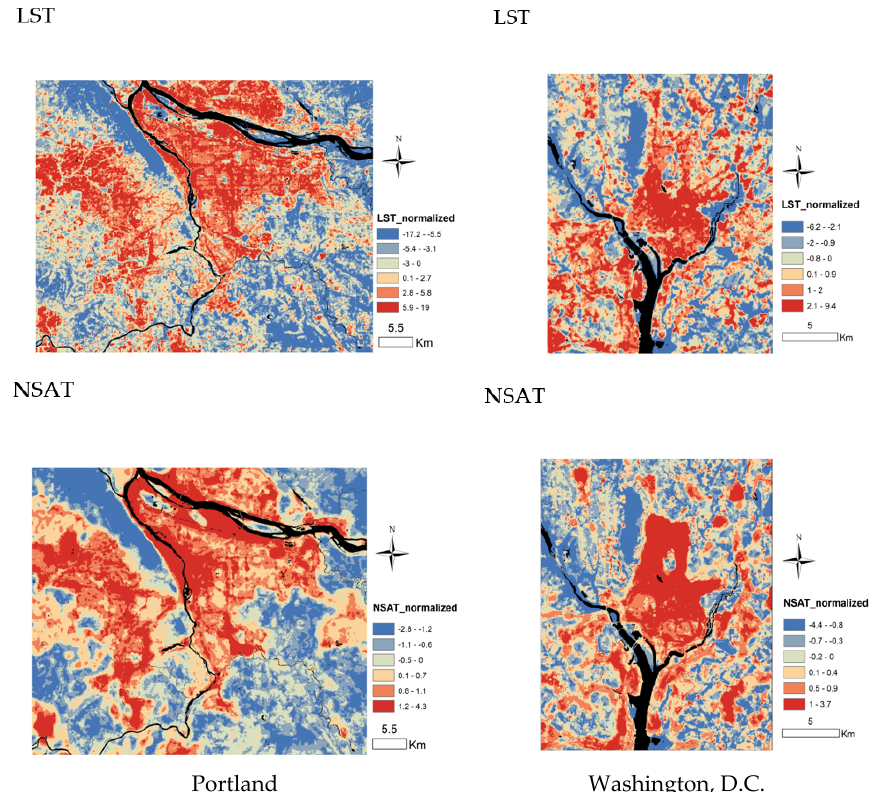
Figure 2. LST and NSAT maps for Portland, Oregon ( left ), Washington, D.C. ( right ).